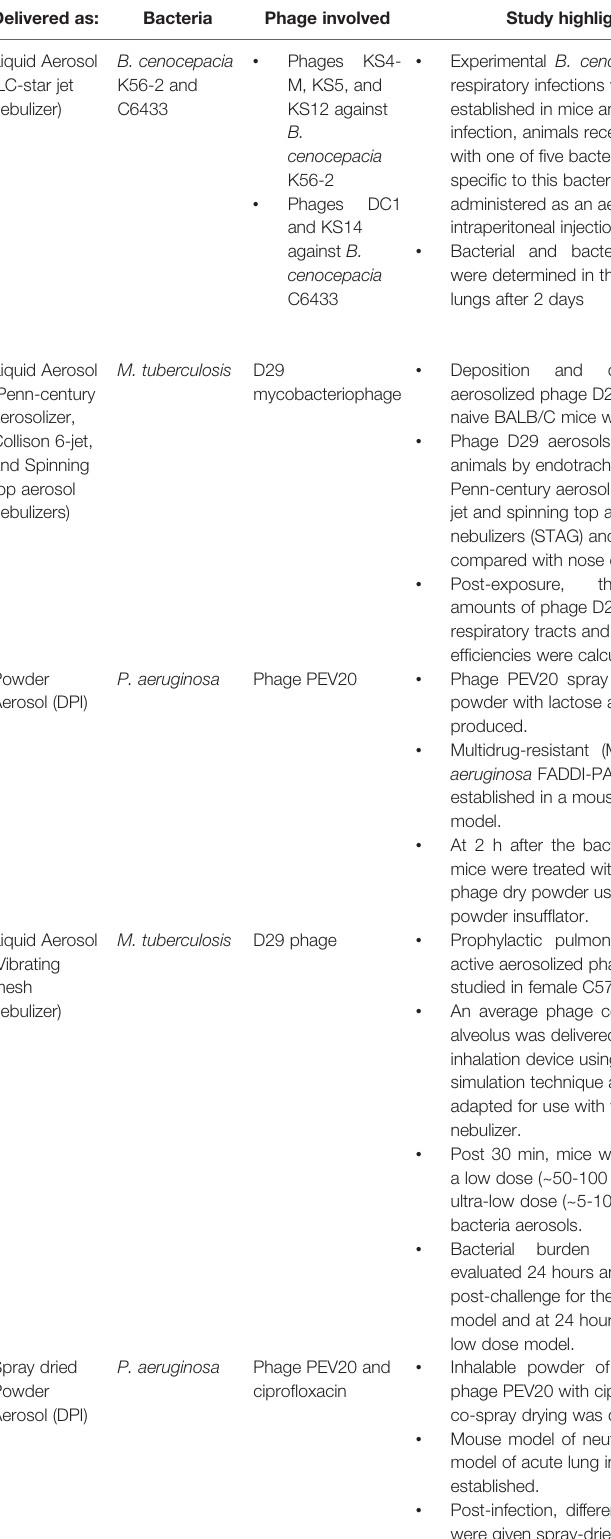
TABLE 1 | Treatment outcomes of recent in vivo ef fi cacy studies and clinical case studies in which different inhalation delivery methods were used in animal